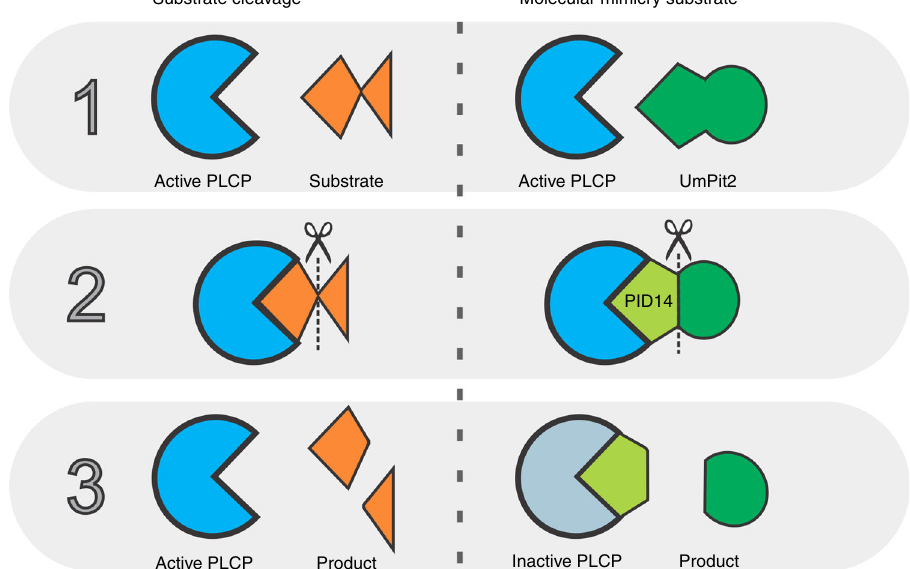
Fig. 8 Pit2 effector act as molecular mimicry. Mechanism of substrate cleavage by active PLCPs (left panel) consisting of substrate recognition (1), substrate cleavage (2) and product release (3). To avoid activation of the immune system, U. maydis secretes the apoplastic effector Pit2 that contains the PID motif of 14 amino acids. In the molecular mimicry substrate model (right panel), active PLCPs recognize Pit2 as a substrate (1). Next, PLCPs cleave Pit2 similar to endogenous substrates (2). While cleavage products endogenous substrates are released from the active site, the inhibitory portion of Pit2 embedded in the PID14 remains bound to the PLCP and thereby blocks its